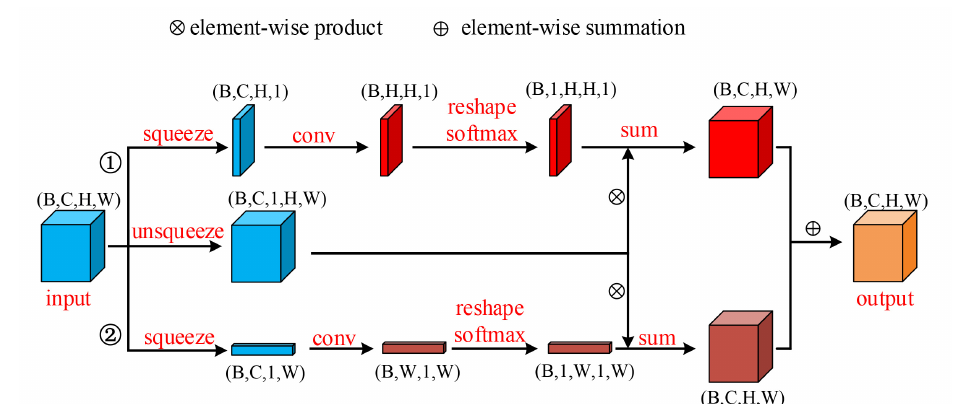
Figure 5. Detailed structure of the row-column self-attention mechanism.